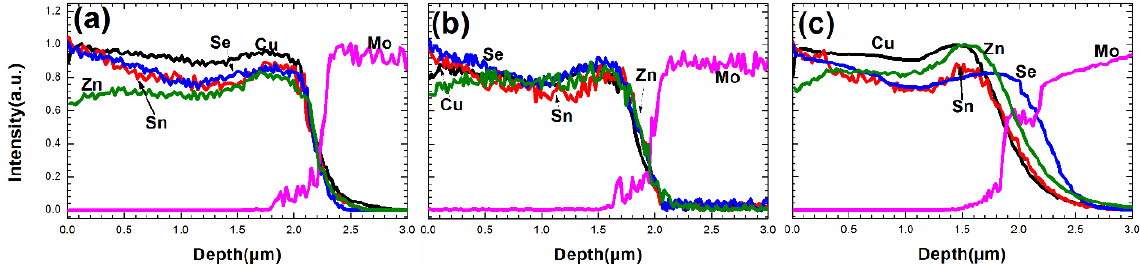
Figure 9. The secondary ion mass spectroscopy (SIMS) depth profiles of the CZTSe films that were